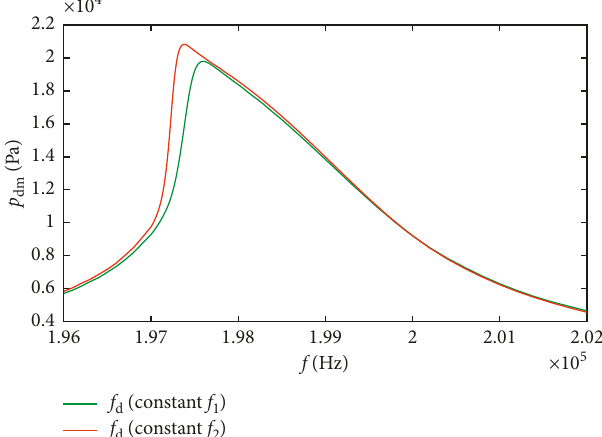
Figure 5: Maximum difference-frequency pressure amplitude in the cavity p in Case 1 (constant f constant f